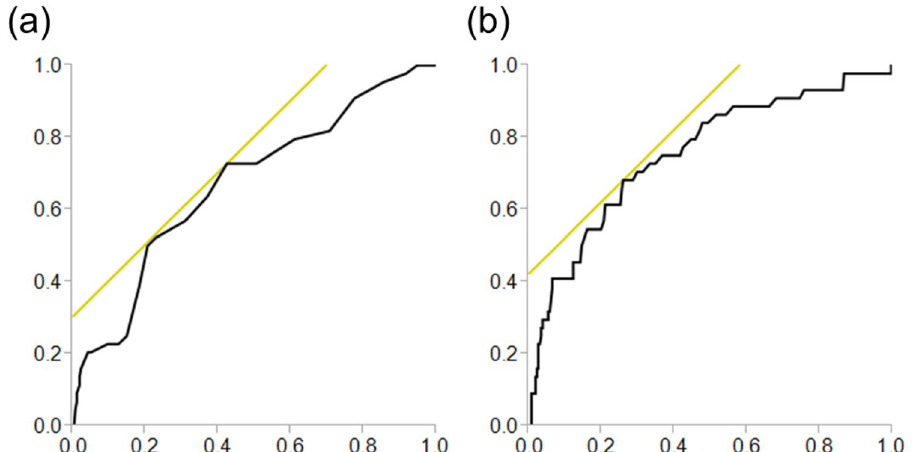
Figure 2. Receiver operating characteristic curves for albumin and the neutrophil to lymphocyte ratio for predicting early acute kidney injury. ( a ) albumin, ( b ) neutrophil to lymphocyte